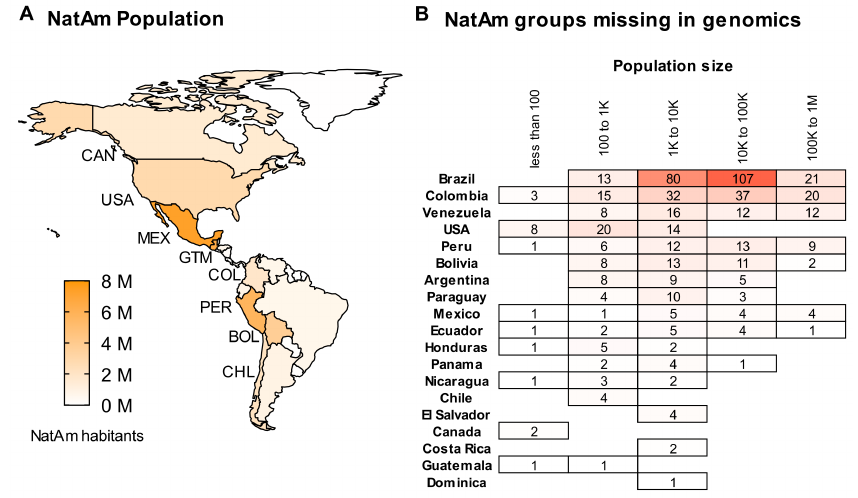
Figure 1. Native American home countries and the missing diversity. ( A ) The map highlights the indigenous population distribution across the continent, with labels on the countries with NatAm pop- ulations of over one million (Canada, USA, Mexico, Guatemala, Colombia, Peru, Bolivia, and Chile); color in the map indicates the number of Native American habitants in each country. ( B ) The heatmap shows the number of indigenous groups that do not have representation in genomic databases; these were found by cross-referencing census data with ethnicities reported in the published genomic studies included in this